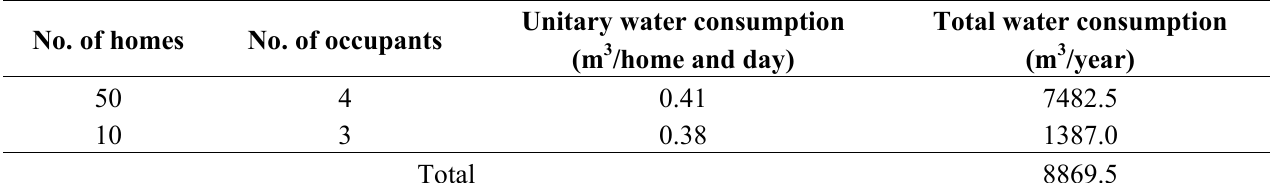
Table 6. Total water consumption of the